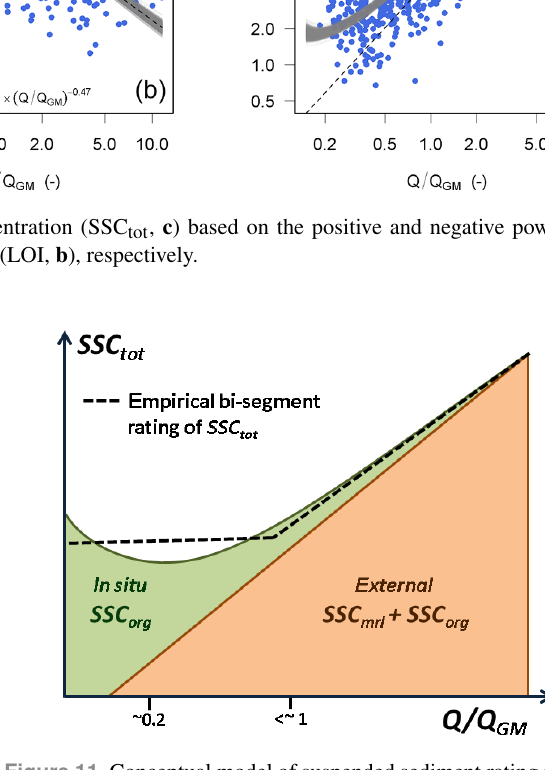
Figure 11. Conceptual model of suspended sediment rating in Ger- man